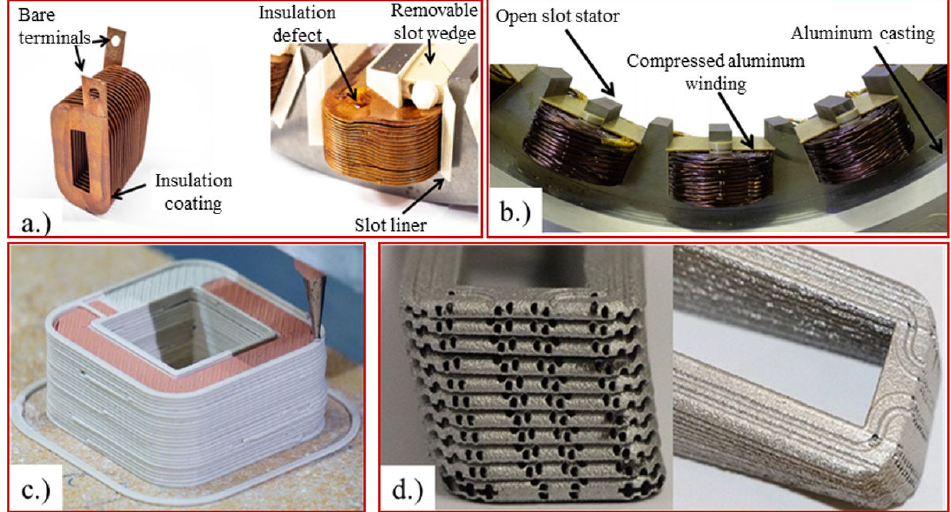
Figure 2. Examples of AM-built windings ( a , b ) AM-built shaped-profile, electrically insulated winding [39] ( c ) MM-AM built winding assembly with integrated ceramic insulation [13] ( d ) AM- built tooth-coil winding with integrated liquid-cooling channels